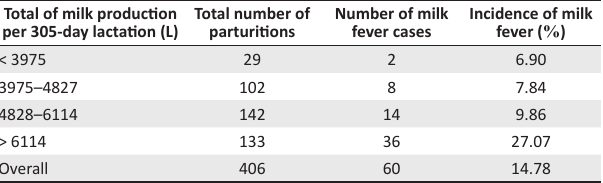
TABLE 4: Incidence of milk fever according to milk yield in Jersey cows. Total of milk production Total number of per 305-day lactation (L)